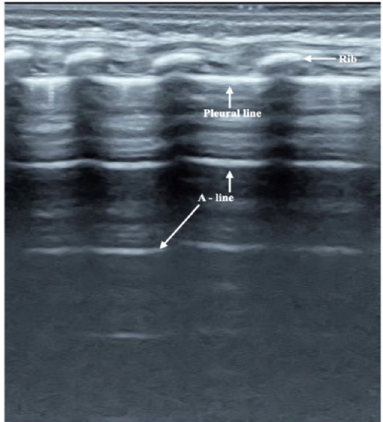
Figure 1. Normal Lung Ultrasound Manifestation. On B-mode ultrasound, the pleural line and A-line were parallel to each other, which formed a kind of bamboo-like ultrasound image, i.e., the bamboo sign.